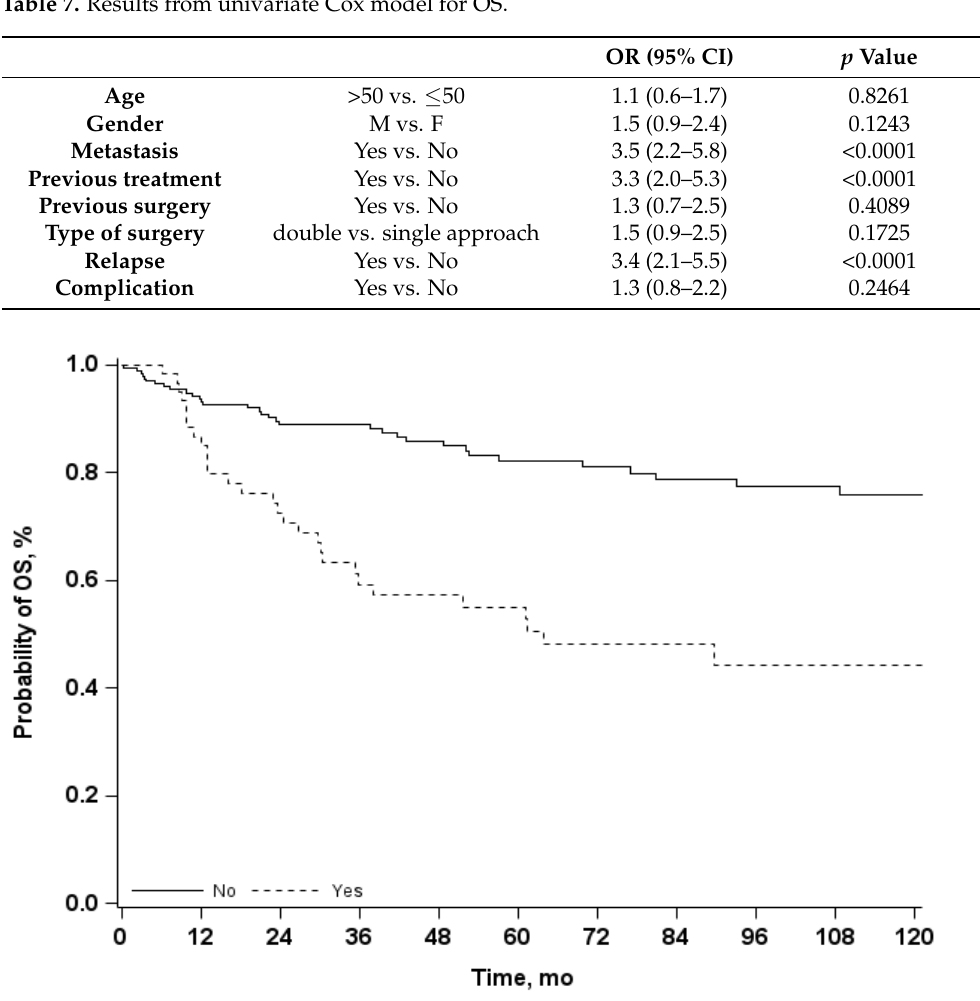
Figure 3. Overall Survival (OS) curves in patients with and without complications; mo = months.